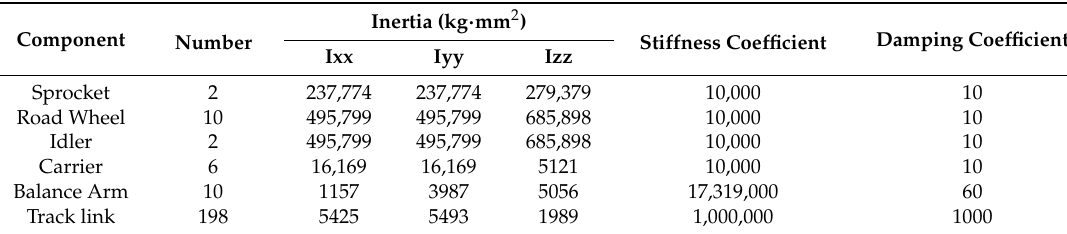
Table 5. Dynamic simulation